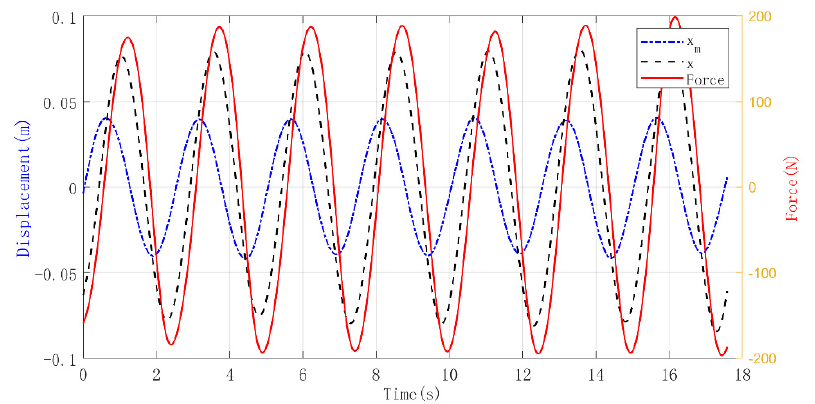
Figure 12. Time history of the servomotor displacement, heave plate displacement, and measured control force.